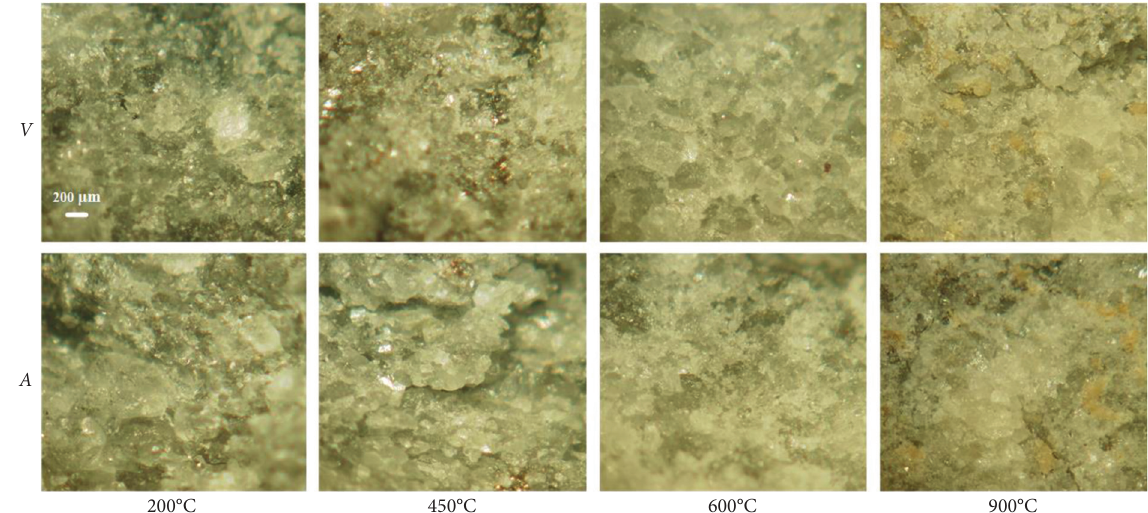
Figure 7: Optical microscopy results of limestone after heat treatment.